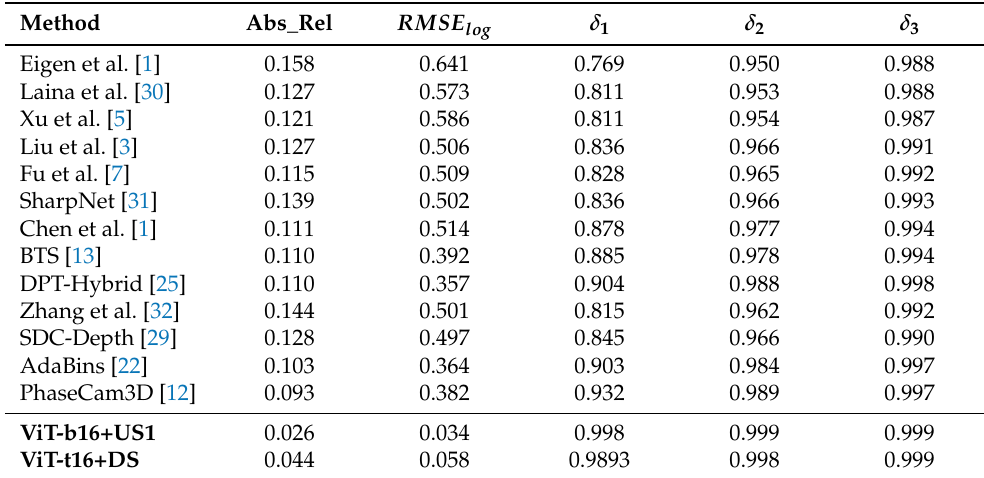
Table 2. Comparison between the proposed method (specifically ViT-b16+US1 and ViT-t16+DS) and the SOTA methods on NYU-depthv2 depth estimation validation-set with respect to the Abs_Rel, RMSE log , and the delta accuracies ( δ 1 , δ 2 , and δ 3